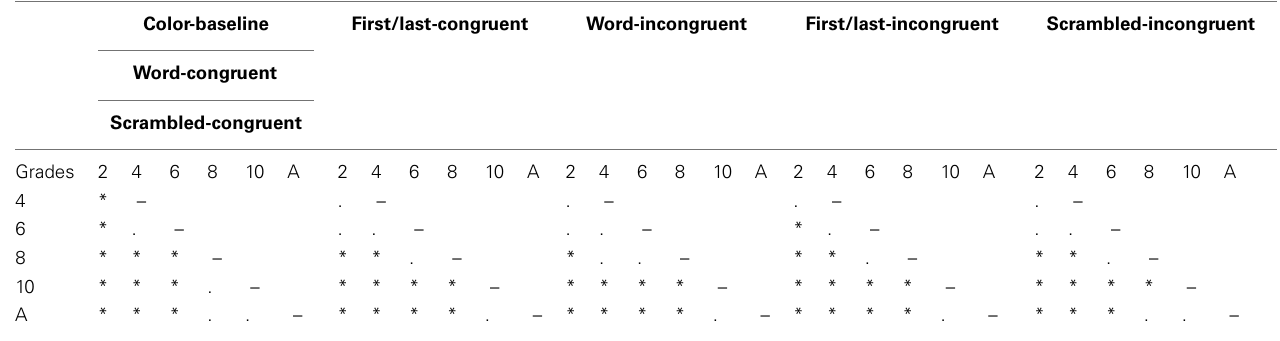
Table 2 | Significant Post hoc Age differences per trial type.